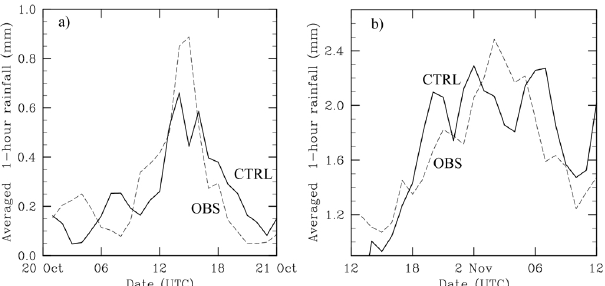
Fig. 5. Comparison of reference experiments (CTRL, bold line) and gauge observation (OBS, dashed line) for (a) the Gard-H´erault case and (b) the C´evennes case. 1-h rainfall at gauge sites, averaged over the box drawn on Fig.